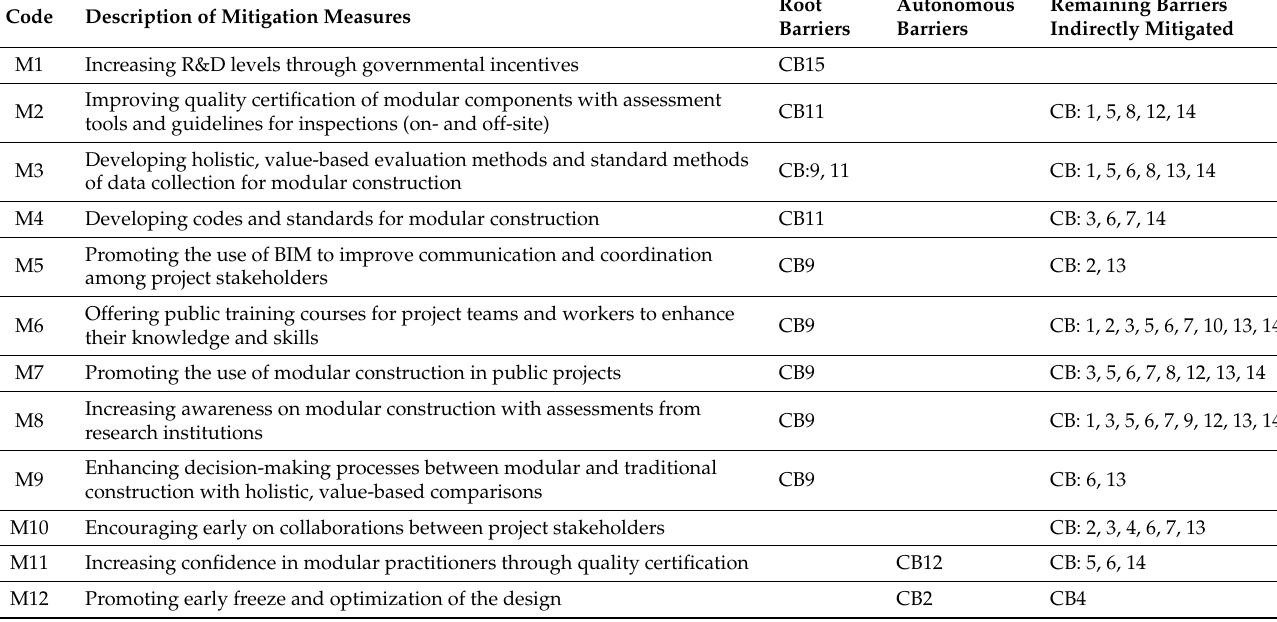
Table 8. List of mitigation measures for the barriers to AMC in